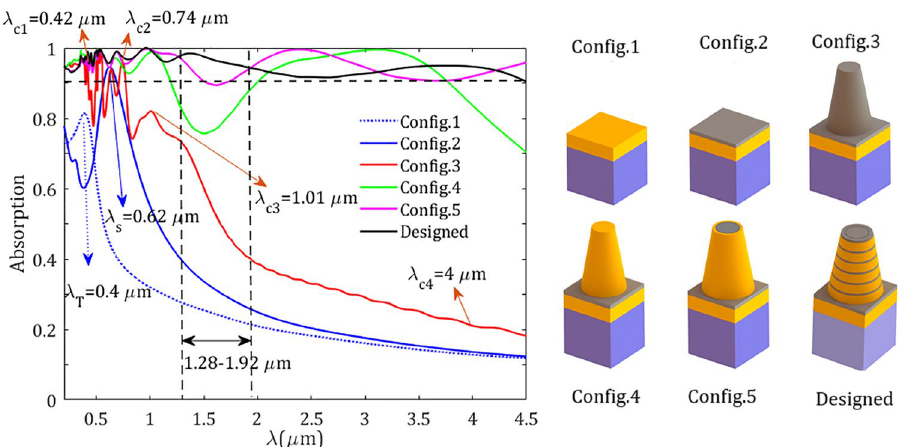
Figure 6. Absorption spectra of different configurations. The resonance wavelengths (cid:31) T = 0.4 µ m for Config.1 and (cid:31) s = 0.62 µ m for Config.2 are indicated in the figure. Here, the resonances (cid:31) c 1 = 0.42 µ m , (cid:31) c 2 = 0.74 µ m , (cid:31)